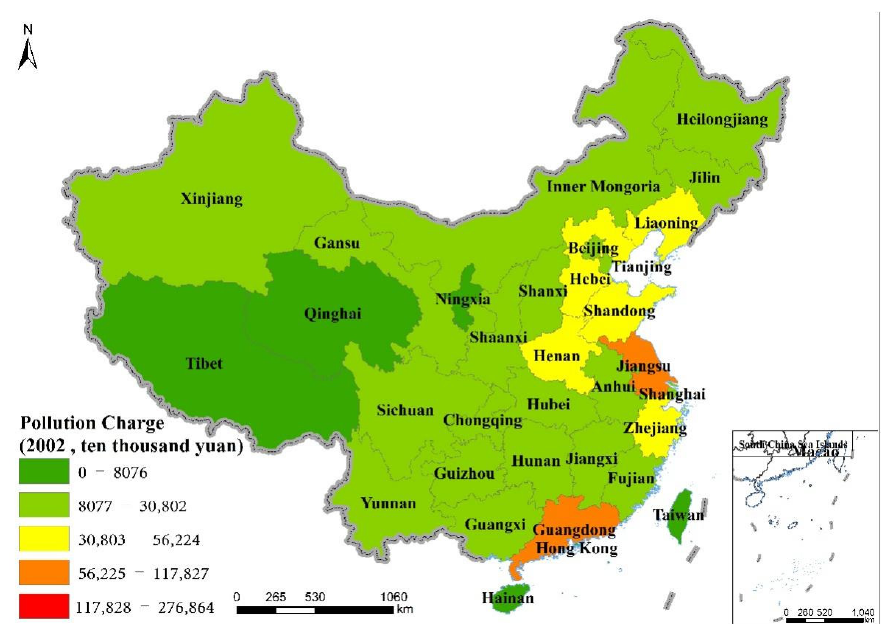
Figure 2. China’s pollution charges in 2002.